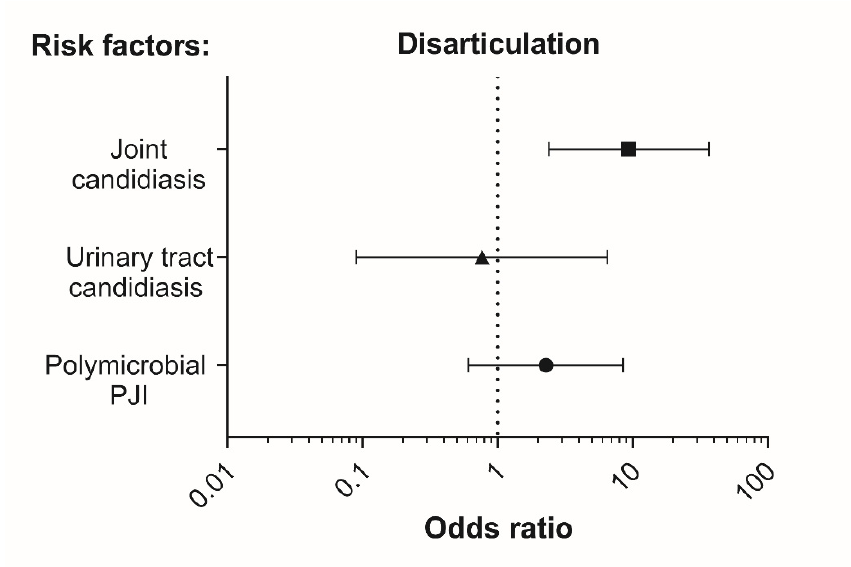
Figure 3. Association of disarticulation with microbial risk factors. Demonstration of the occurrence of disarticulation of the affected limb in relation to polymicrobial infection, candidiasis of the urinary tract, and candidiasis of the affected joint. Odds ratios are depicted as means ± 95% confidence intervals.